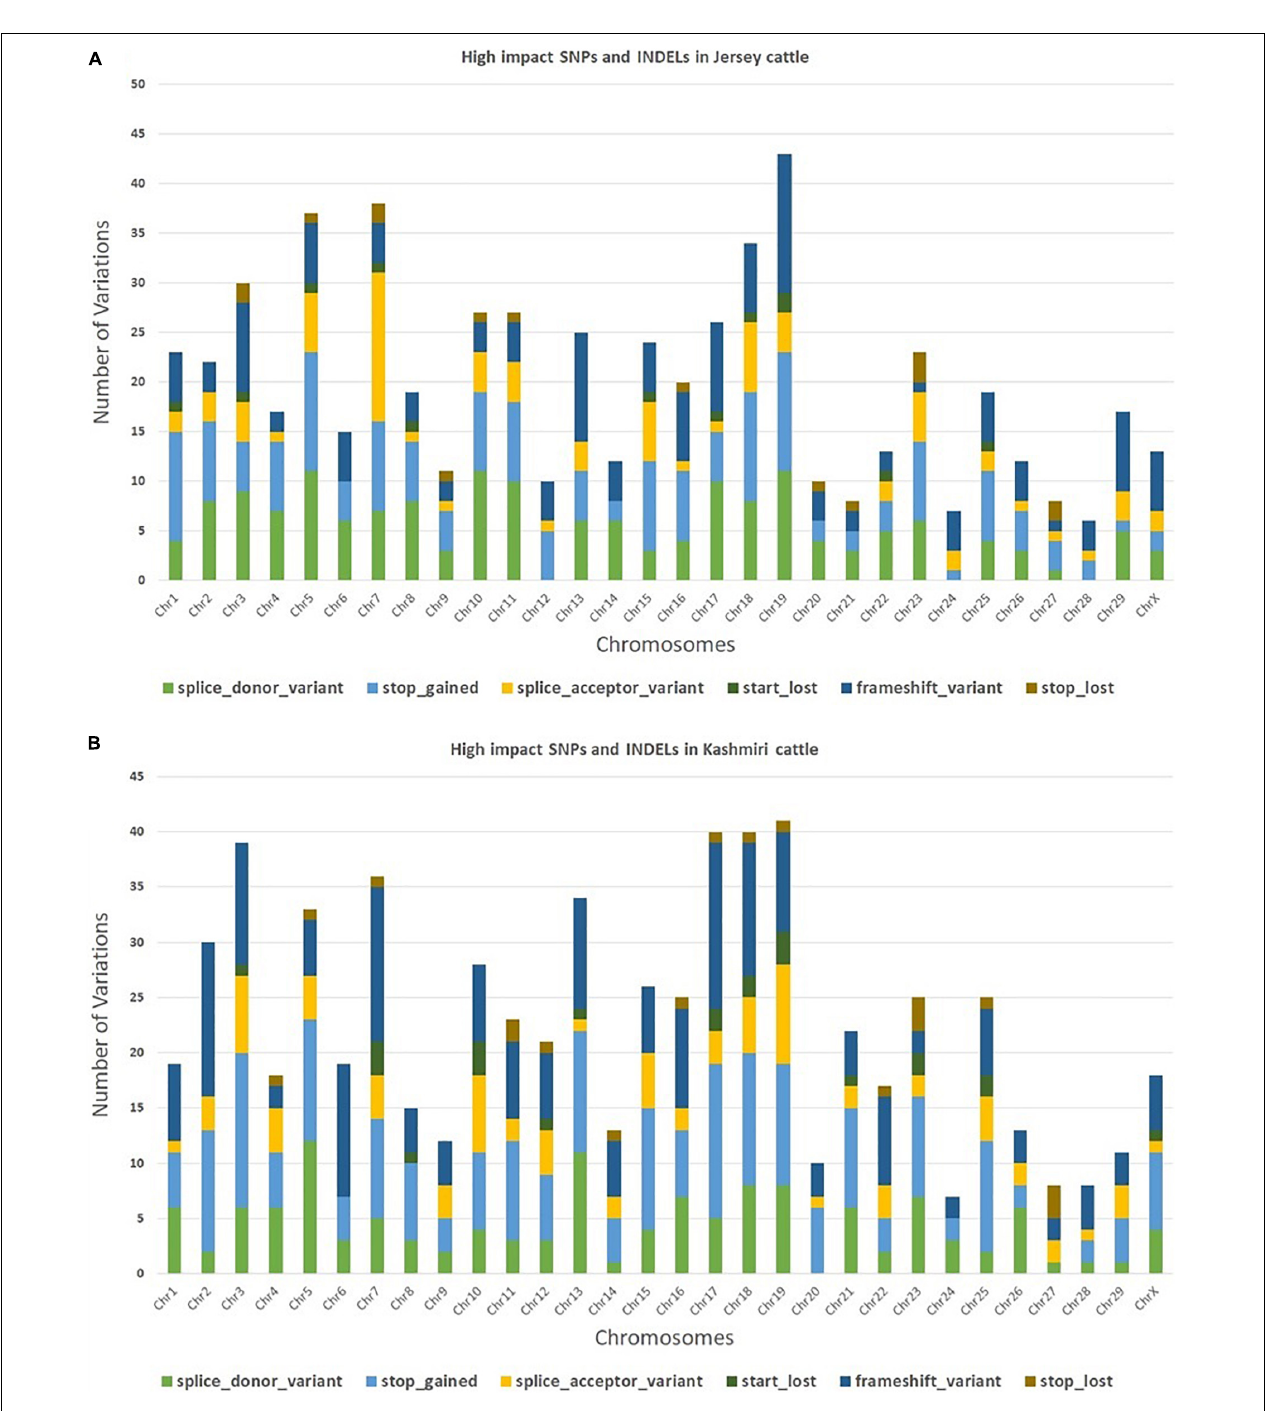
FIGURE 1 | Chromosomal distribution of high impact SNPs and Indels in Jersey (A) and Kashmiri (B)